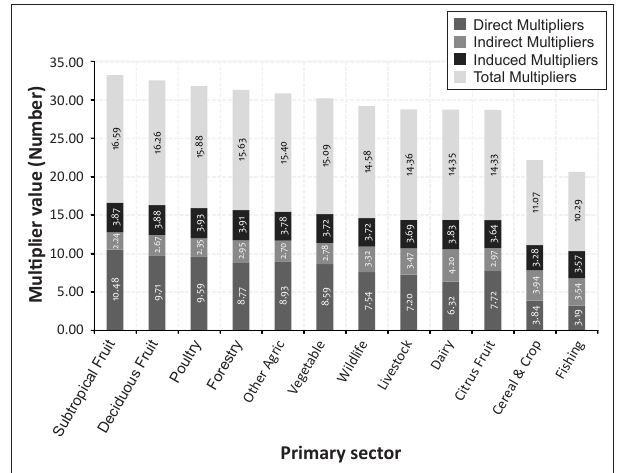
FIGURE 5: Gross domestic product/Value added multipliers versus percentage labour contribution. FIGURE 6: Employment multipliers.